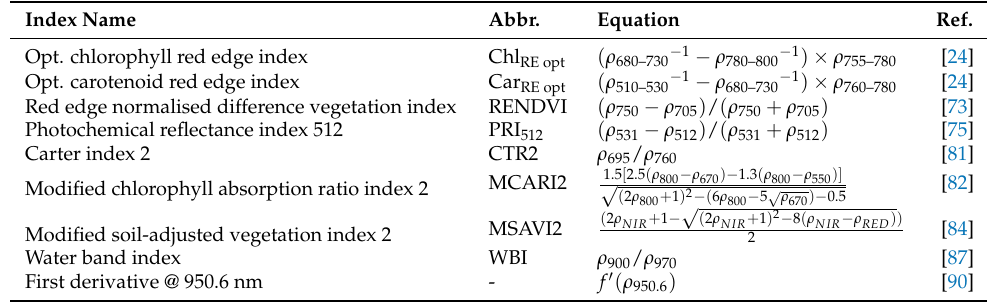
Table 3. List of vegetation indices used for evaluation of the SiVM-based stress level estimates ( ρ denotes reflectance at a specific wavelength or wavelength